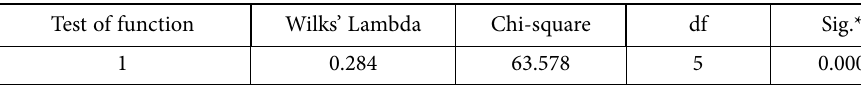
Tabel 4. Wilks’ Lambda (source: authors’ processing) Test of